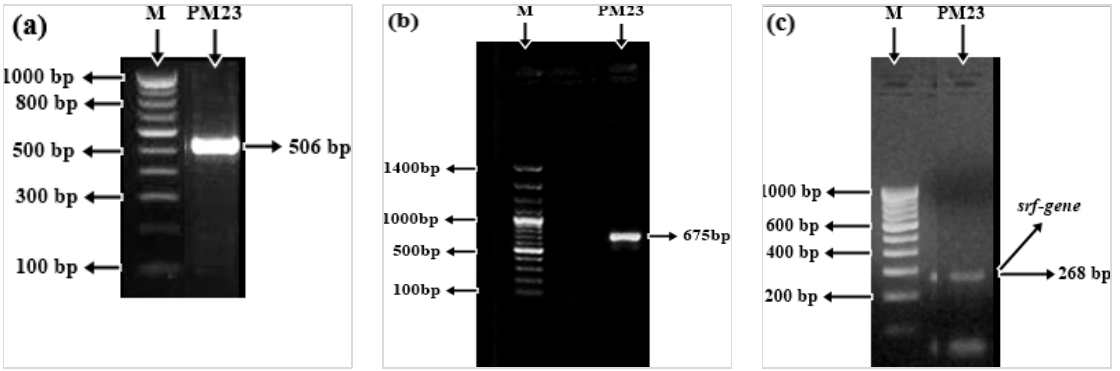
Figure 6. Amplification of biotic and abiotic stress-related genes: ( a ) ItuC-gene ( b ) sfp-gene ( c ) srfAA- gene. (M) represents marker.